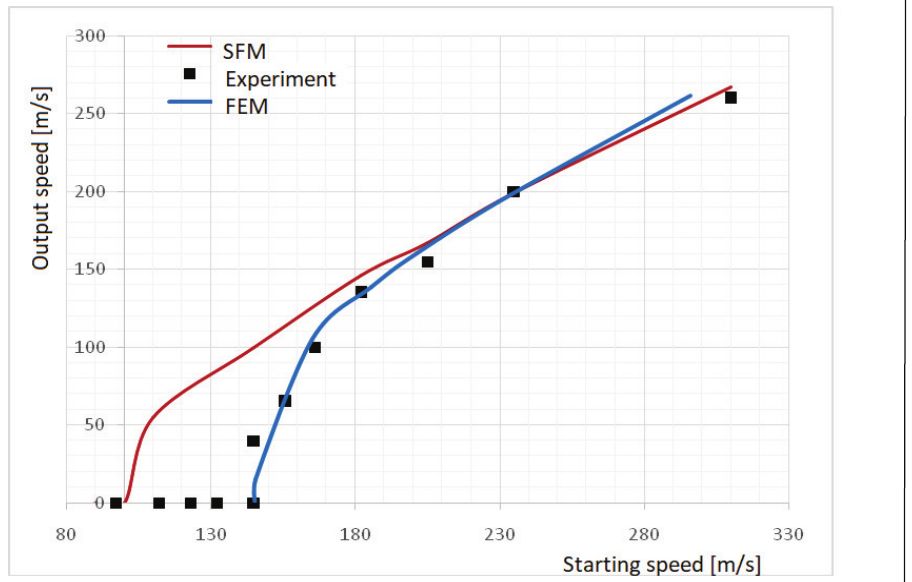
Figure 22 – Comparison of the results obtained by the FEM and SFM methods for a 6 mm thick steel plate, with a blunt projectile